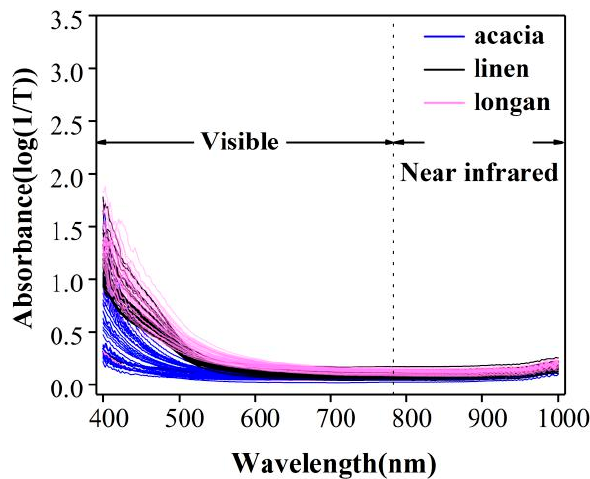
Figure 2. Visible (400–780 nm) and near-infrared (780–1000 nm) spectra of all the 110 honeys samples. Vis/NIR spectra of acacia ( n = 37), linen ( n = 35) and longan ( n = 38) honeys.